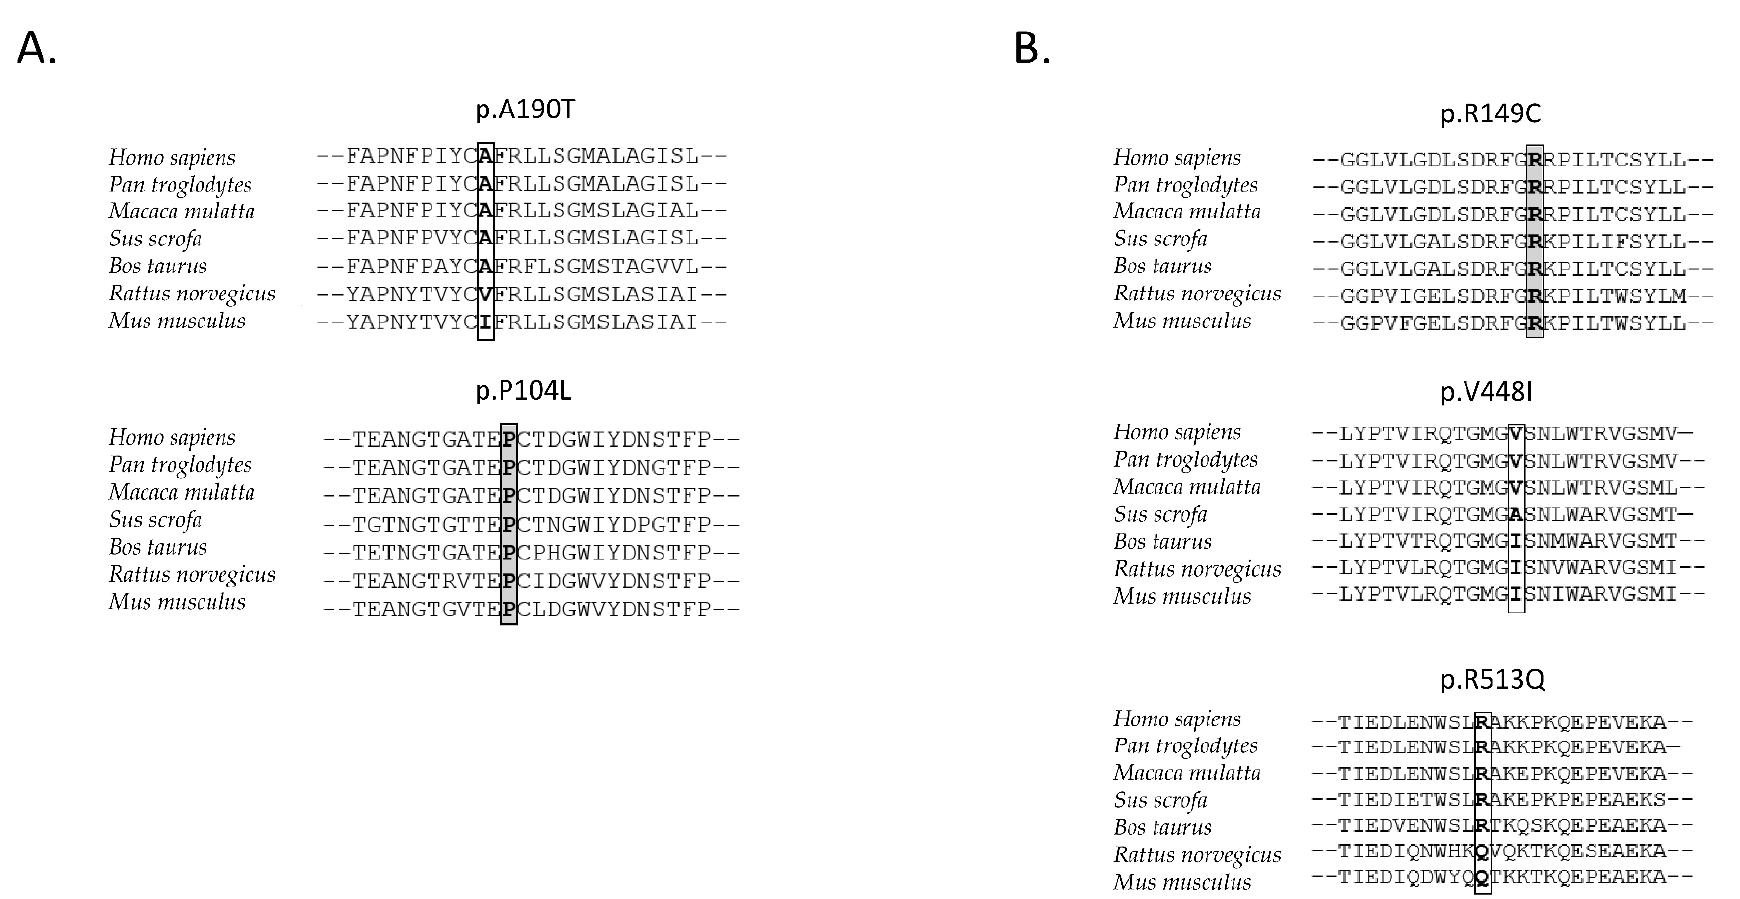
Figure 3. ( A ) OAT1 ( SLC22A6 ) evolutionarily conserved amino acids among seven mammalian species. The position of non-synonymous substitution among seven species is indicated with grey fill. Identity with human OAT1 Pan troglodytes 97.3%, Macaca mulatta 94.7%, Sus scrofa 86.5%, Bos taurus 84.2%, Rattus norvegicus 85.9%, and Mus musculus 83.3%. ( B ) OAT3 ( SLC22A8 ) evolutionarily conserved amino acids among seven mammalian species. The position of non-synonymous substitution among seven species is indicated with grey fill. Identity with human OAT3: Pan troglodytes 99.4%, Macaca mulatta 96.3%, Sus scrofa 81.7%, Bos taurus 81.7%, Rattus norvegicus 78.8%, and Mus musculus 77.5%, performed by using the UniProt Align tool